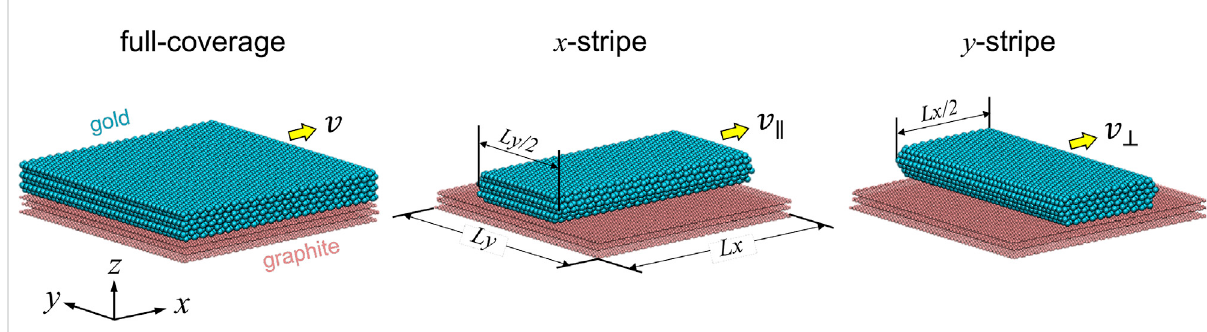
FIGURE 1 Snapshots of three simulation models at rest. Yellow arrows indicate the sliding direction, that is, if motion is parallel (||) or perpendicular ( ⊥ ) to the contact line. L x and L y are 11.5 and 11.6 nm,